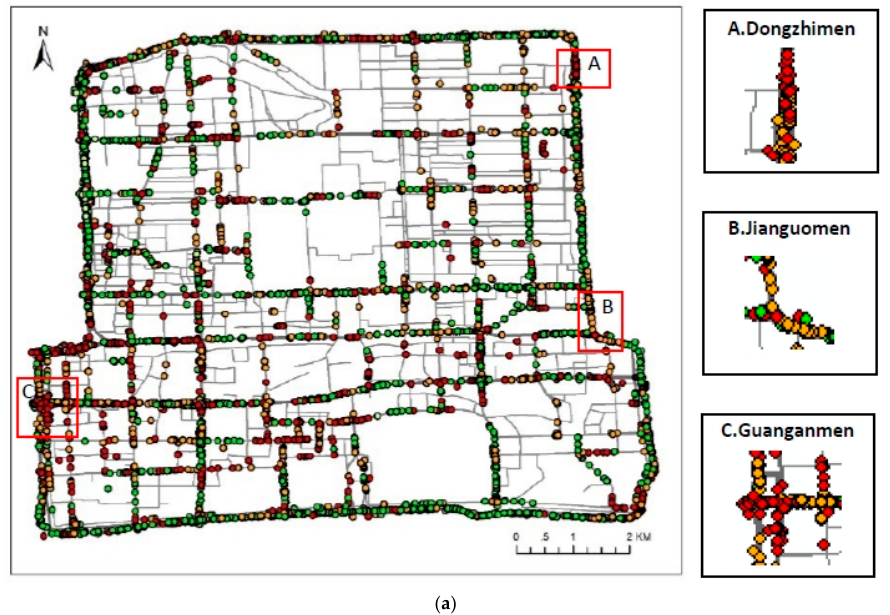
Table 6 indicates that the average ARP values for the k-means algorithm, AP algorithm, and